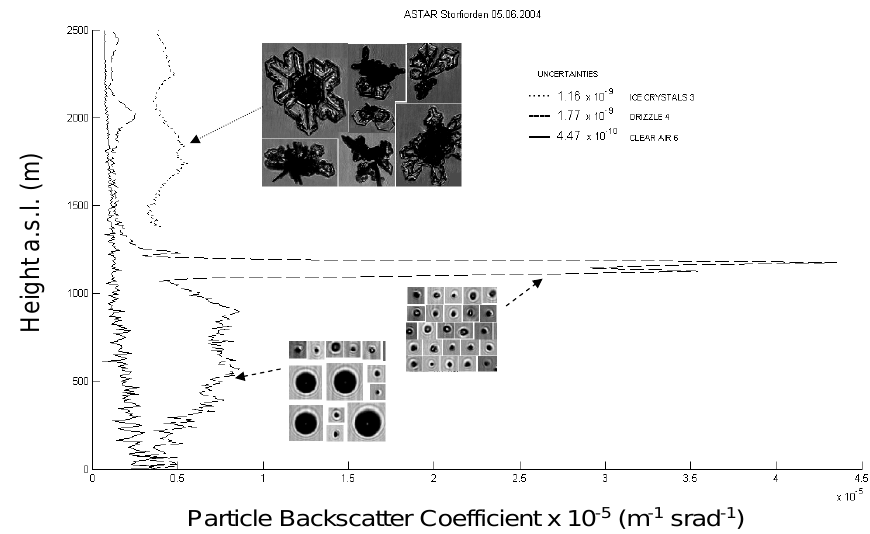
Fig. 5. Vertical profiles of particle backscatter coefficient retrieved for the selected regions in Fig. 3 of: (i) drizzle fallstreak (dashed line), (ii), ice crystals (dotted line) and (iii) cloud-free atmosphere (solid line) from the AMALi measurements at 532nm. Some CPI images exemplify water drops and ice crystals to